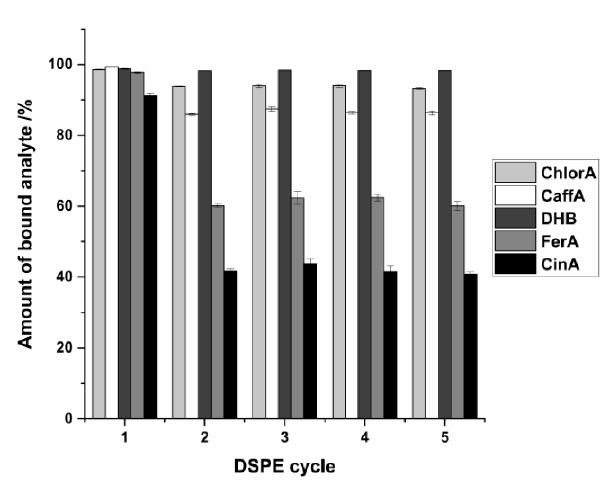
Figure 6. Binding results after performing multiple DSPE cycles with the poly(n-VIM/C 6 -bis-VIM) polymer with a monomer to crosslinker ratio of 11.50 to 1. Standard deviations are given as error bars.